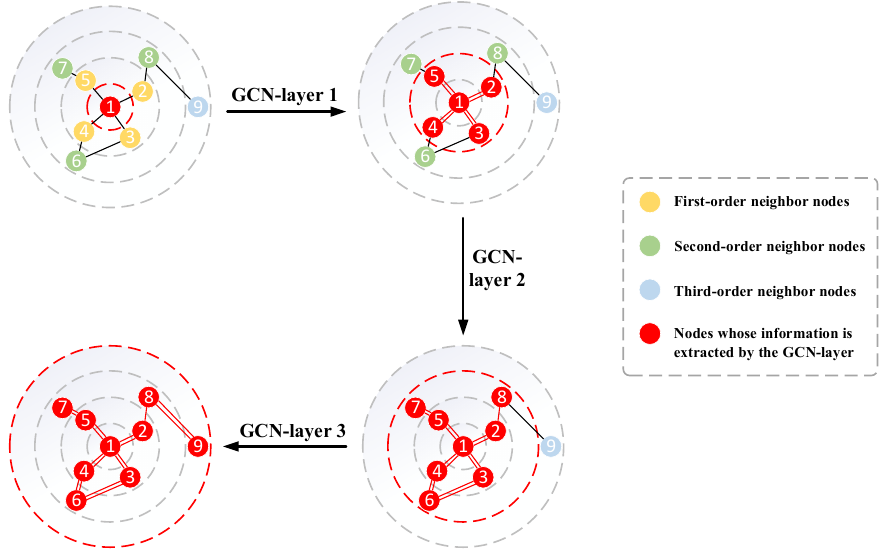
Figure 1. Schematic diagram of GCN extracting spatial features.